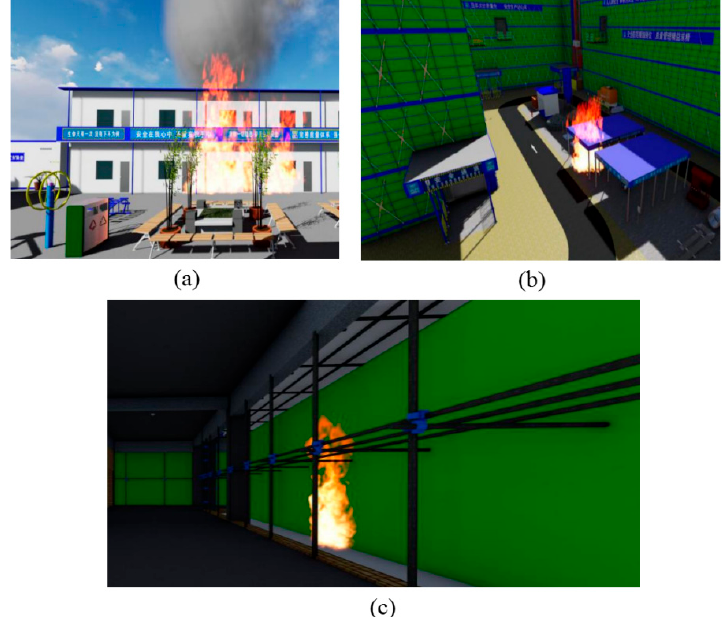
Figure 14. Fire visualization at: ( a ) living area; ( b ) flammable material area; ( c ) scaffold.